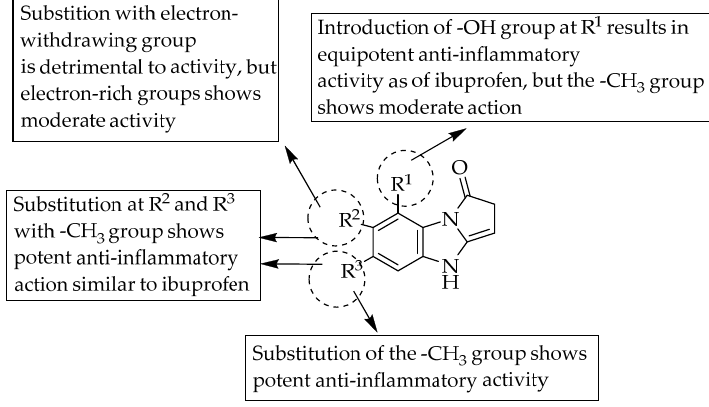
Figure 46. SARs of tricyclic benzimidazoles.